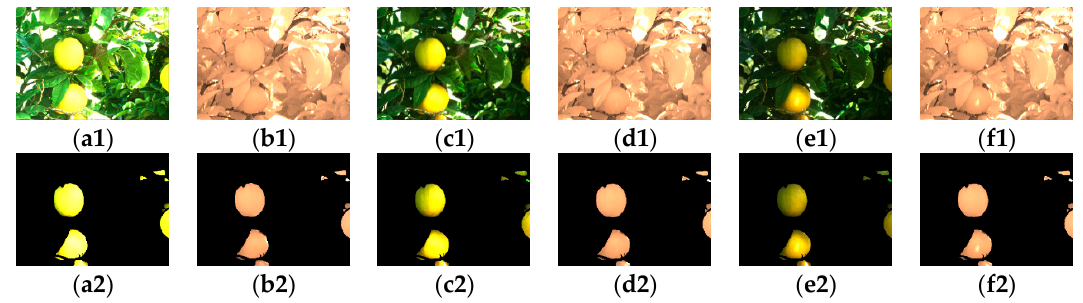
Figure 3. Segments of citrus fruit foreground for the calculation of standard deviation, ( a1 ) is a normal color image (VIS); ( b1 ) is the corresponding NIR image of ( a1 ); ( c1 ) is a neutral density attenuated image (NEUT); ( d1 ) is the corresponding NIR image of ( c1 ); ( e1 ) is a linear polarizer-attenuated image (POLA); ( f1 ) is the corresponding NIR image of ( e1 ); ( a2 – f2 ) are the corresponding segmented images around the fruit area of the image from the first row respectively. Table 1. STD of RGB components for types of color images.